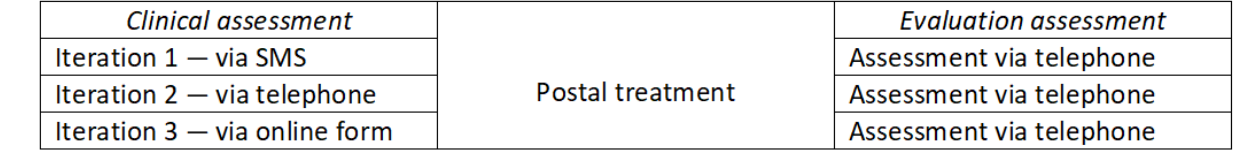
Figure 1. Data collection points and methods.